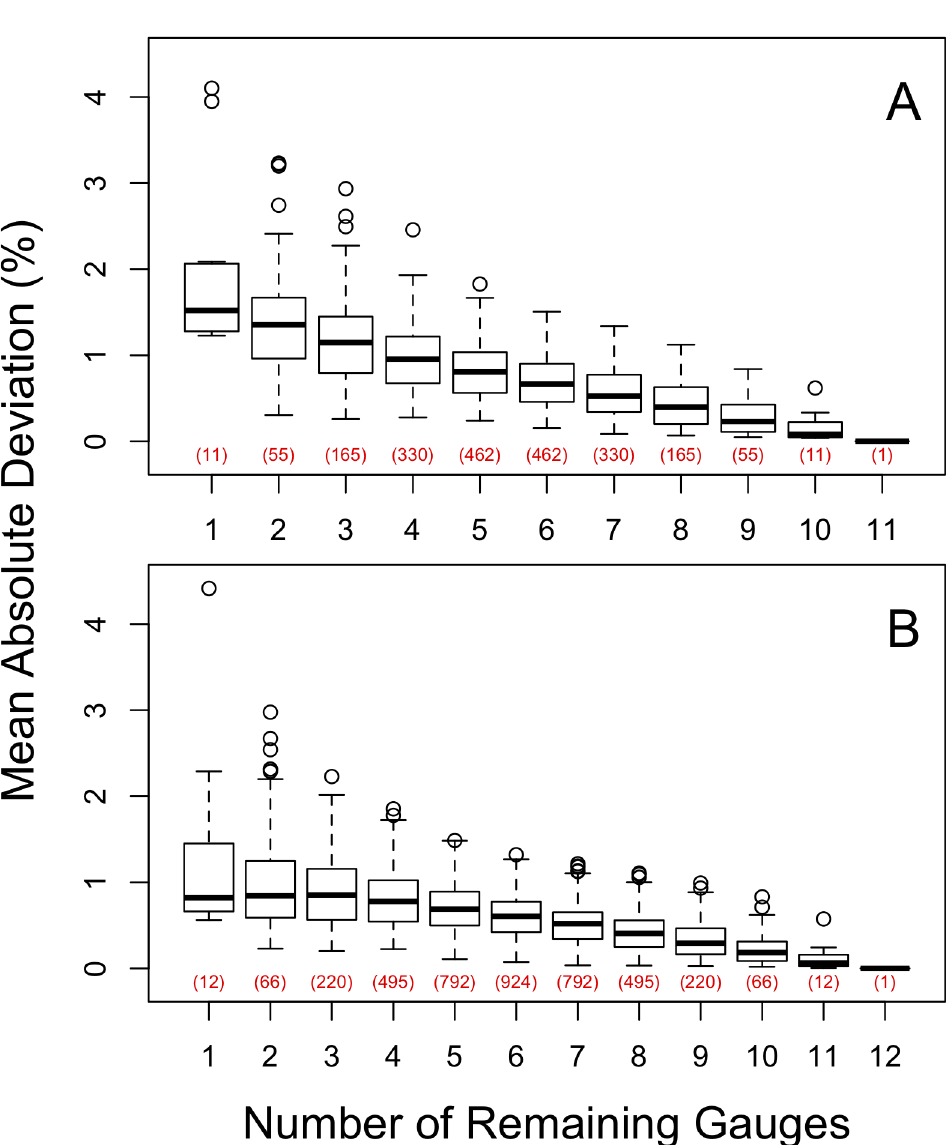
numbers in parentheses indicate the number of unique scenarios for each number of remaining